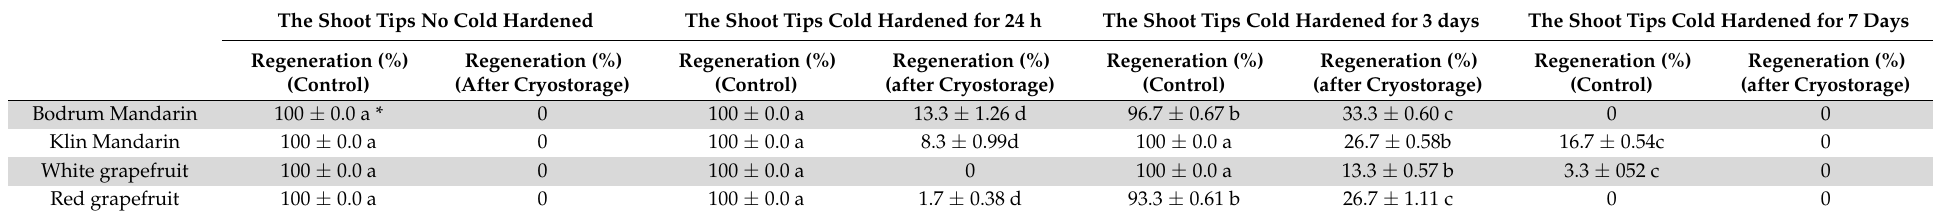
Table 2. The shoot tip regeneration of four different Citrus spp. cultivars cold hardened in different treatment times. The shoot tips treated with PVS2 for 45 min were incubated in regeneration medium for the first 24 h, and then they transferred to WPM medium supplemented with 1 mg.L − 1 BAP, 10 mg.L − 1 activated charcoal, and 1 mg.L − 1 H 3 BO 3 medium for four weeks under standard culture